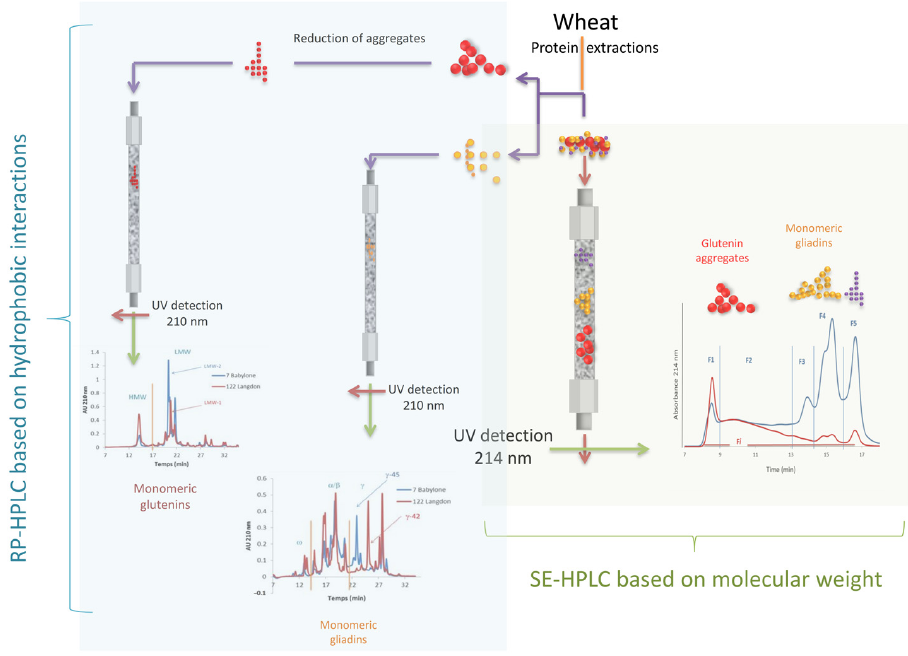
Figure 2. Methodology of chromatographic analysis of wheat